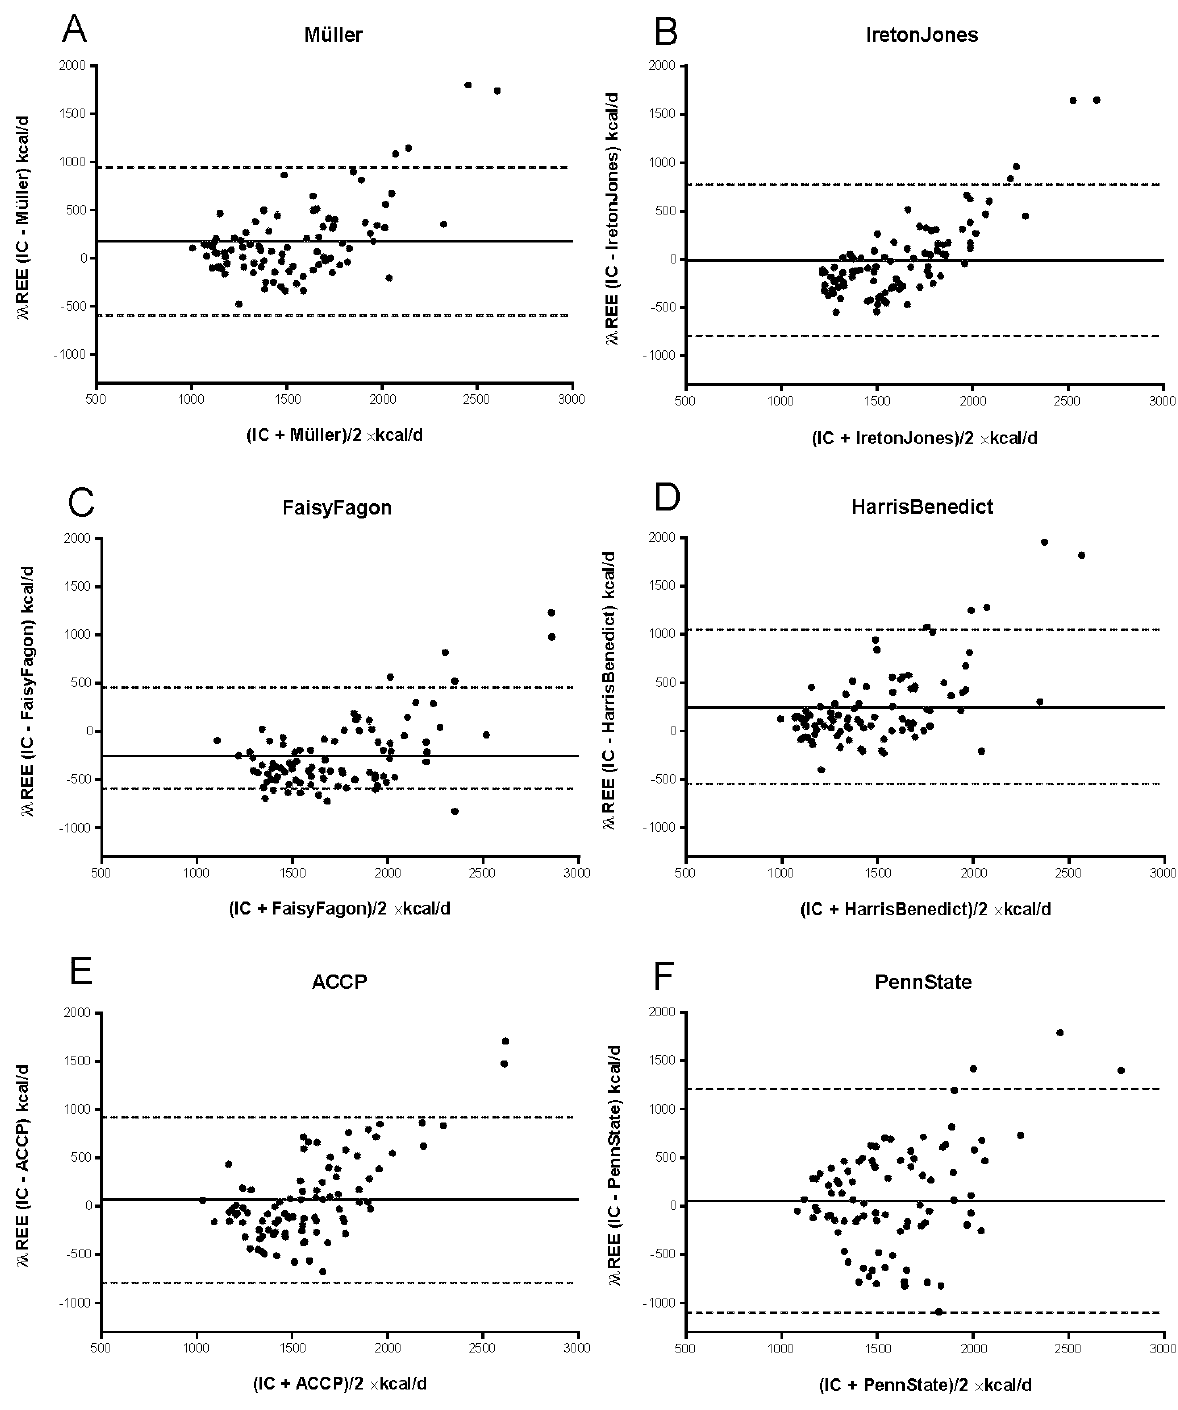
Figure 2. Bland–Altman analyses of measured and calculated resting energy expenditure in the critically ill patient cohort. The difference between the measured and calculated REE ( y axis) is plotted against the mean of REE ( x axis), with each data point corresponding to one patient for the following equations: ( A ) Müller, ( B ) Ireton-Jones and Jones, ( C ) FaisyFagon, ( D ) Harris and Benedict ( E ) ACCP, and ( F ) PennState. Abbreviations. REE: resting energy expenditure, kcal: kilocalories, d: day.